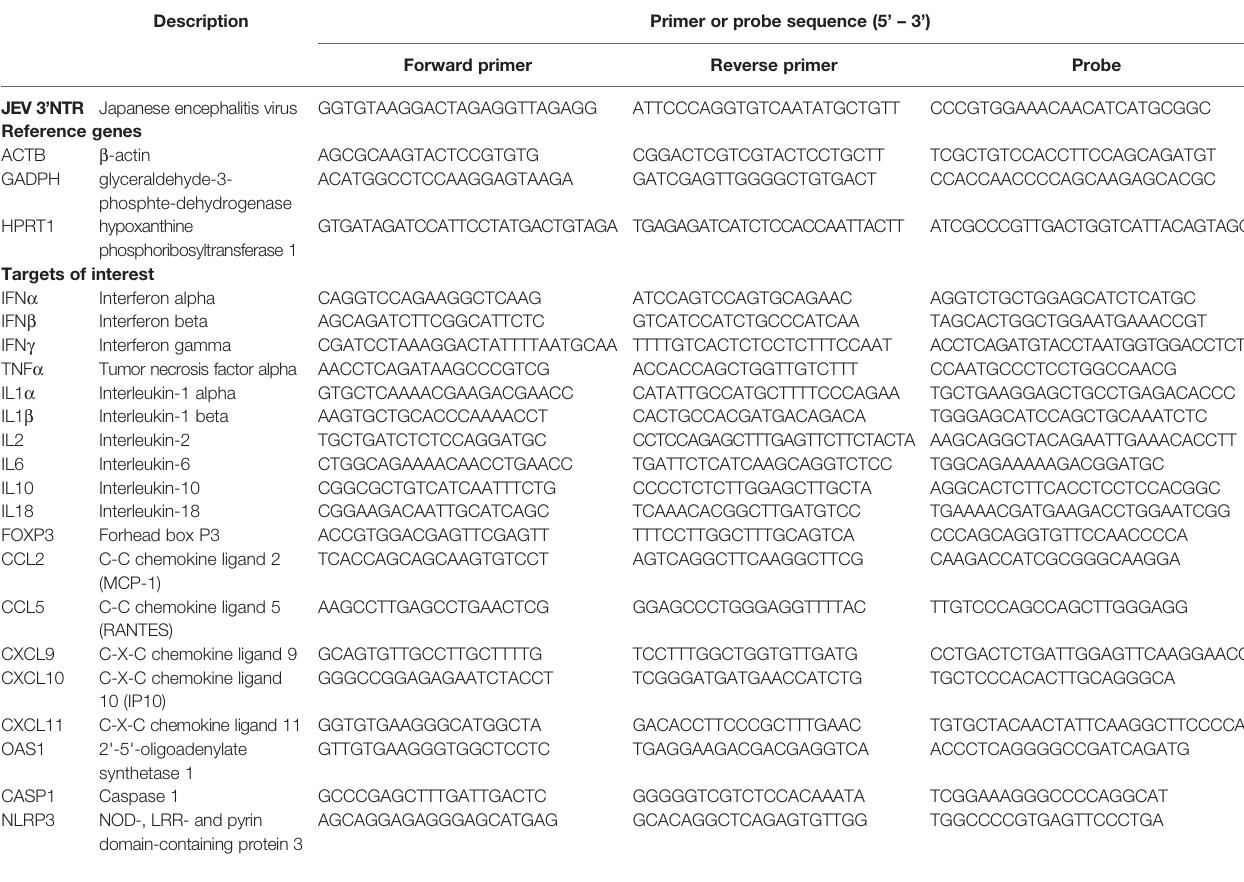
TABLE 1 | Sequences for forward and reverse primers and probes used for mRNA